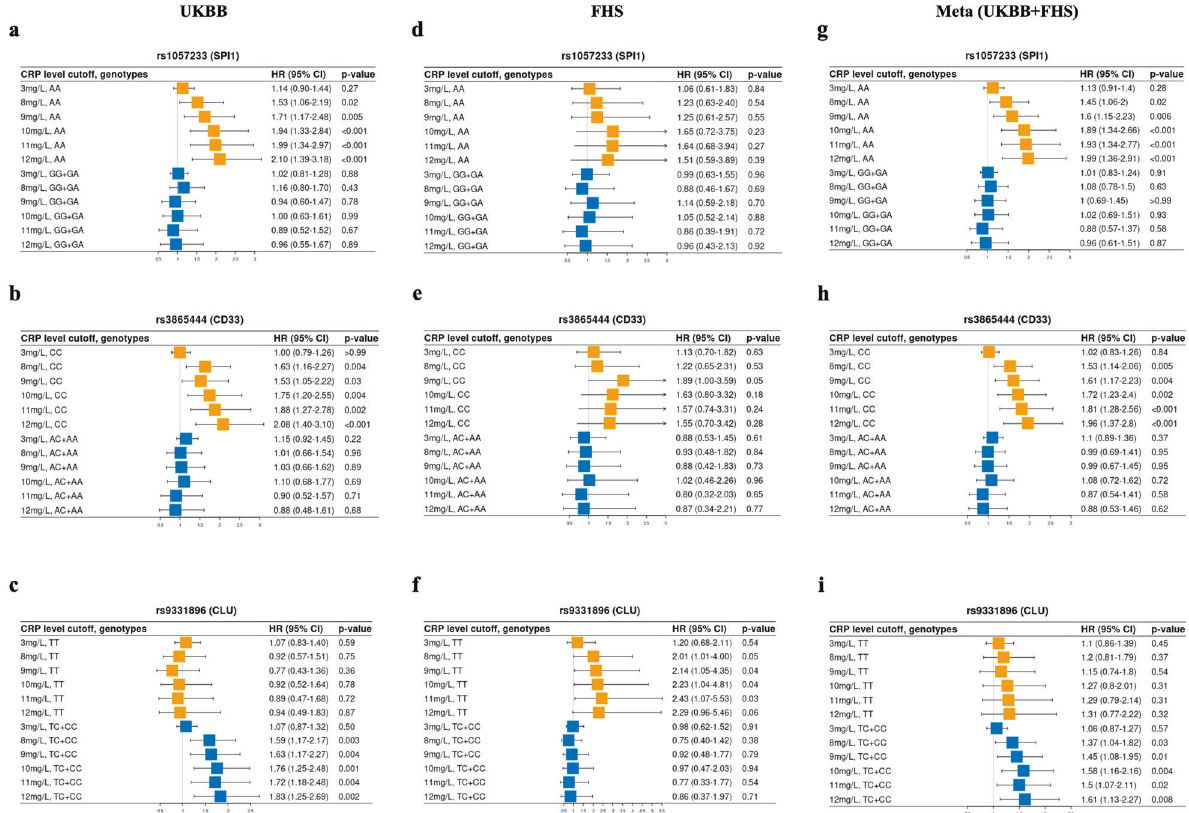
Fig. 3 Forest plots of the results from UKBB, FHS and meta-analysis for the strati fi ed genotype analysis of 3 SNPs for the effect of CRP levels on AD incidence. The Cox proportional hazard regression models were applied to estimate the effect of different levels of serum CRP on the incidence of AD among different genotypes of SPI1, CD33 , and CLU after adjusting for age, sex, years of education, APOE ε 4 and PCs. The results from UKBB are shown (a – c) , and those from FHS are shown (d – f) . The results from the meta-analyses of UKBB and FHS are shown ( g – i ). Raw P values are presented. For all CRP cutoffs from 3 – 12 mg/L, refer to Fig. frequency (21.9% vs. 24.2%), and higher proportion of individuals with AD (5% vs. 0.3%) than UKBB subjects. In addition, the follow- up period from age at CRP measurement to censoring age was longer for FHS than UKBB subjects (average 14.93 vs. 8.45 years). However, the associations of CRP concentration with age, female sex, lower APOE ε 4 carrier frequency and AD risk were similar to those observed in UKBB subjects.